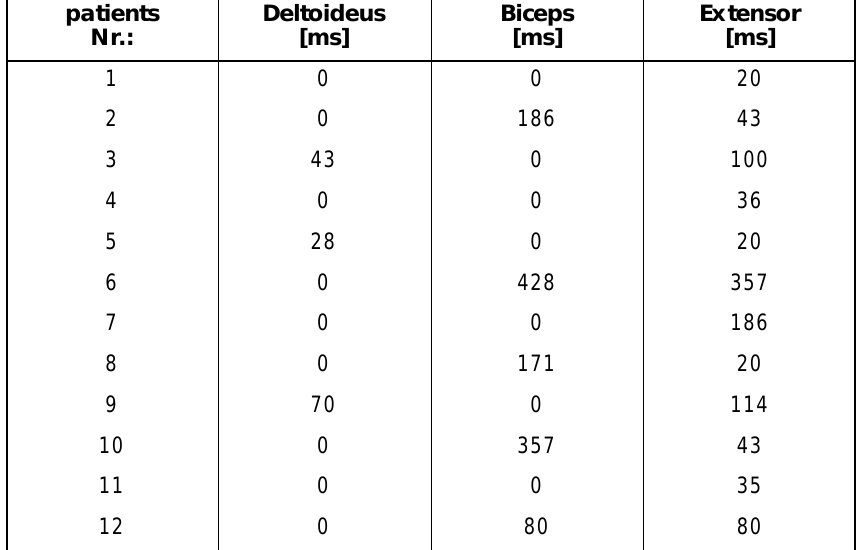
Table 8: Innervation sequences in abduction of hemiparetic